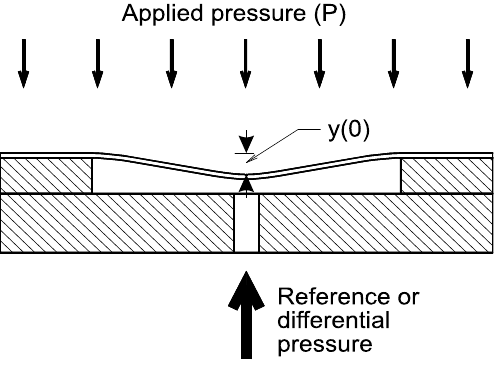
Figure 2. Cross-section of the construction of the LTCC pressure sensor under an applied pressure P , which causes the deflection y (0) in the middle of the